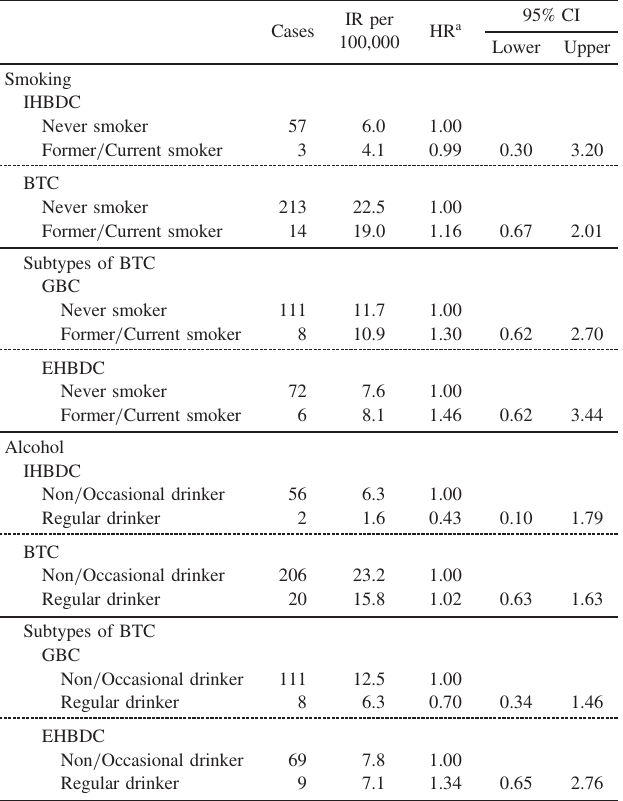
Table 5. HRs and 95% CIs of the incidence of BTC and IHBDC according to smoking and alcohol consumption in